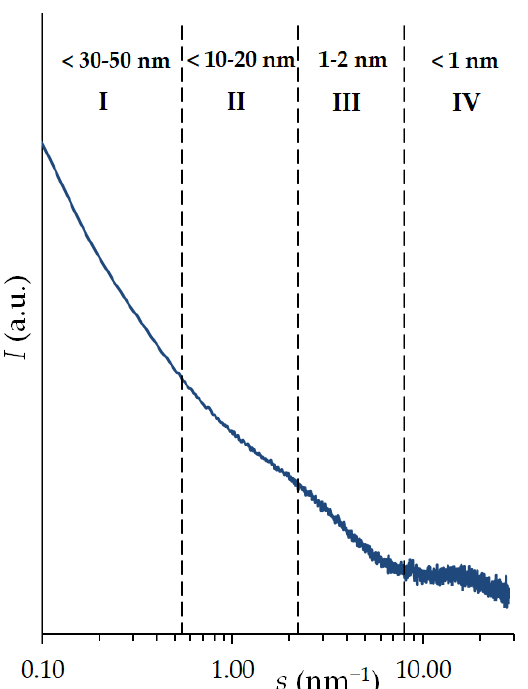
Figure 3. Dependence of the small-angle X-ray scattering intensity on the carbon adsorbent ACPK on the scattering vector at small and medium angles. I – IV are the characteristic X-ray scattering data areas used to obtain the structural parameters of the adsorbents.